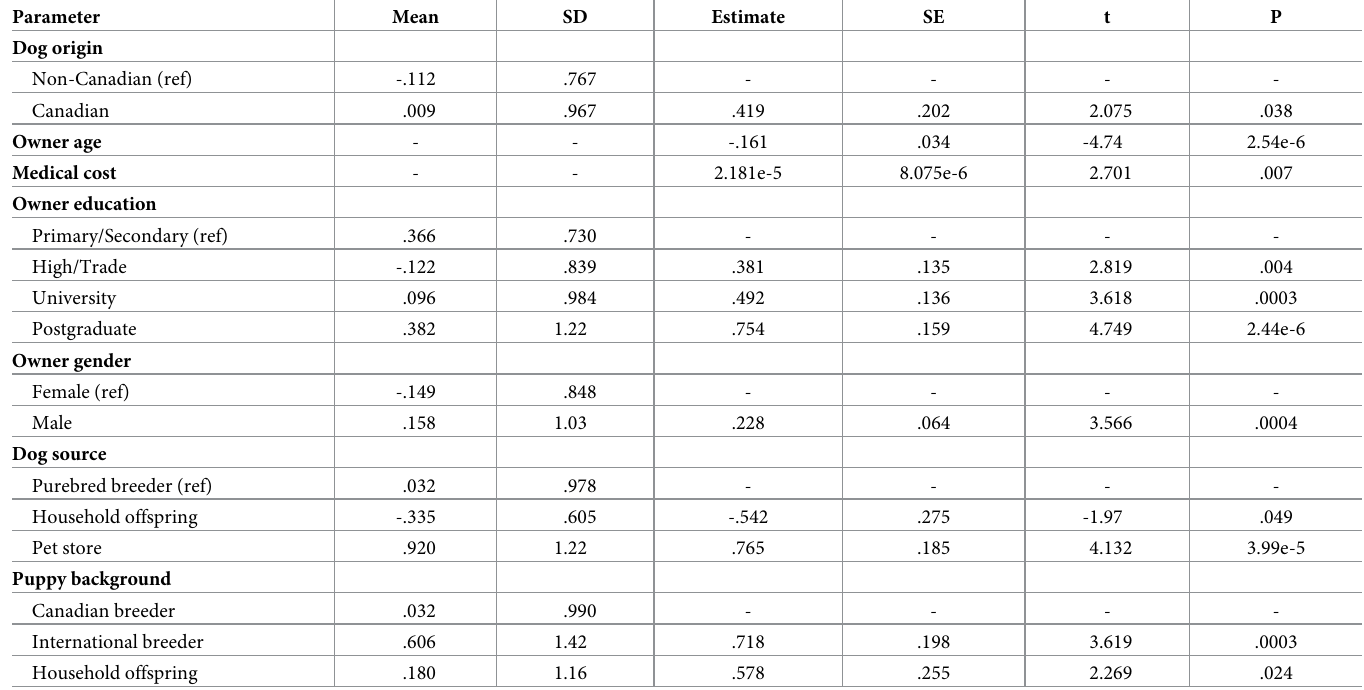
Table 8. Statistically significant interactions of owner and dog parameters on HAB Factor 1 “Regret”.